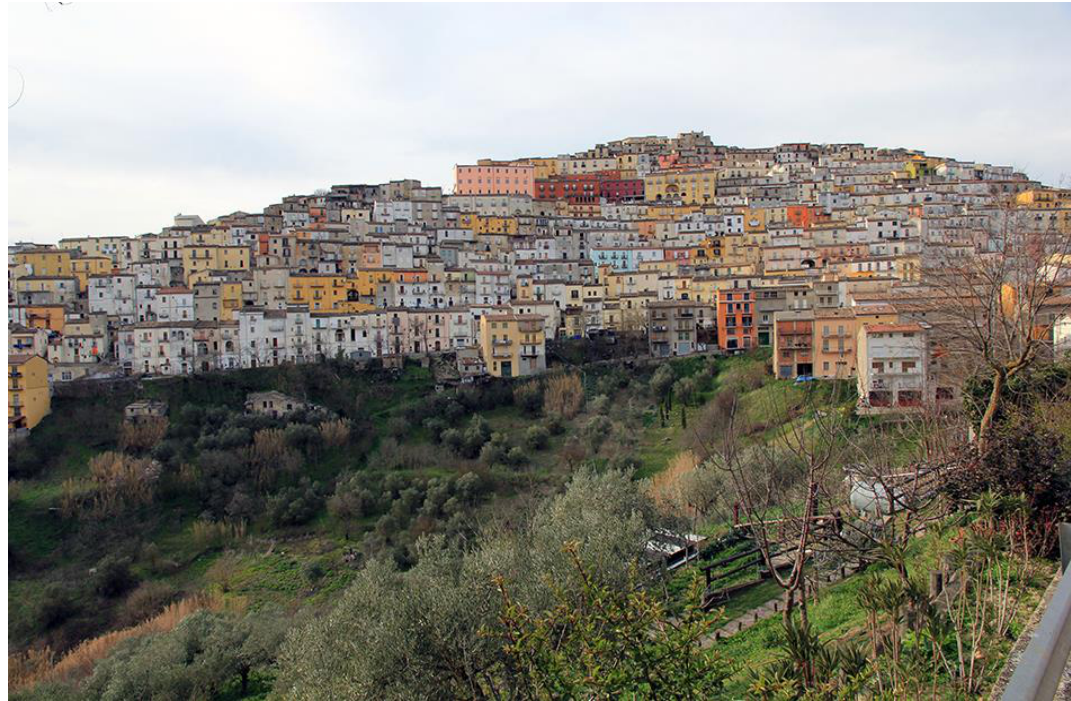
Figure 109. Calitri: panoramic view of the village (photos by [35,36]).